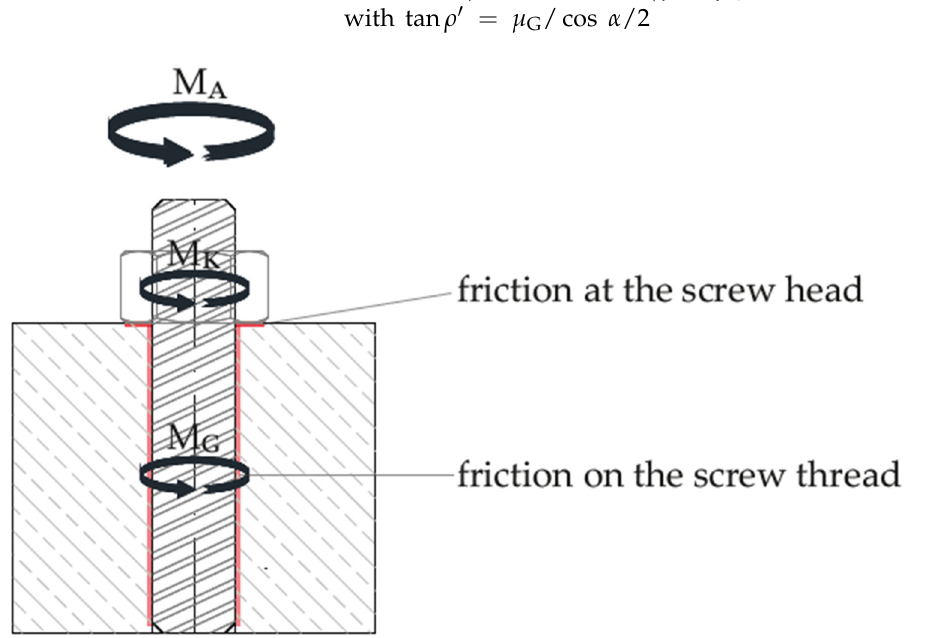
Figure 28. Parts of the tightening torque. (Graphic: CARBOCON